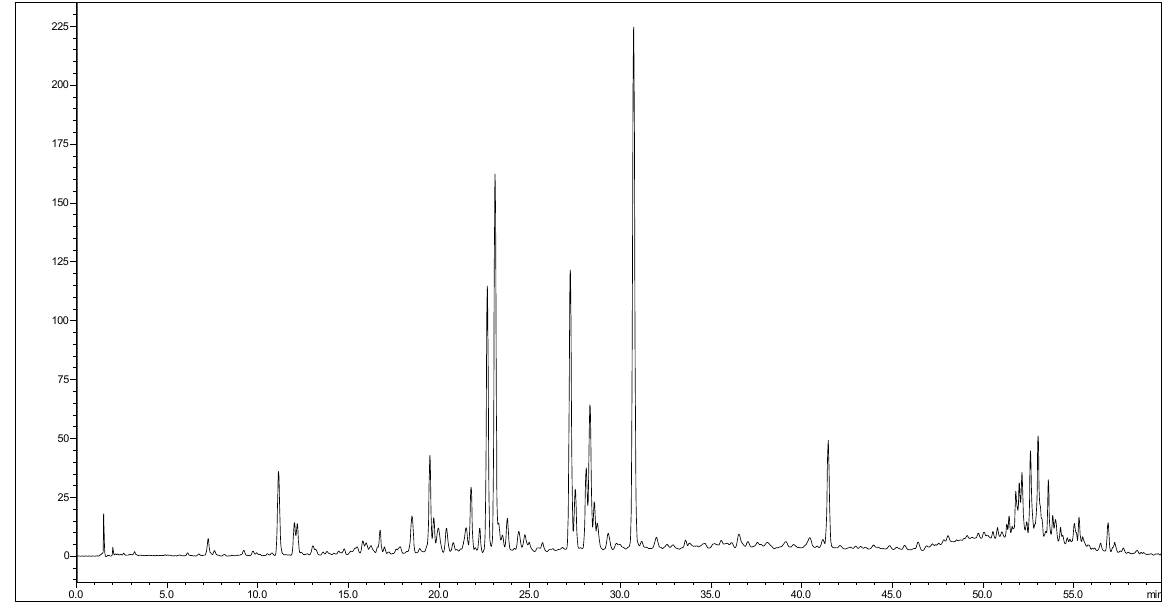
Figure 1. LC chromatogram of H. hemistemon aerial ‐ part extract.